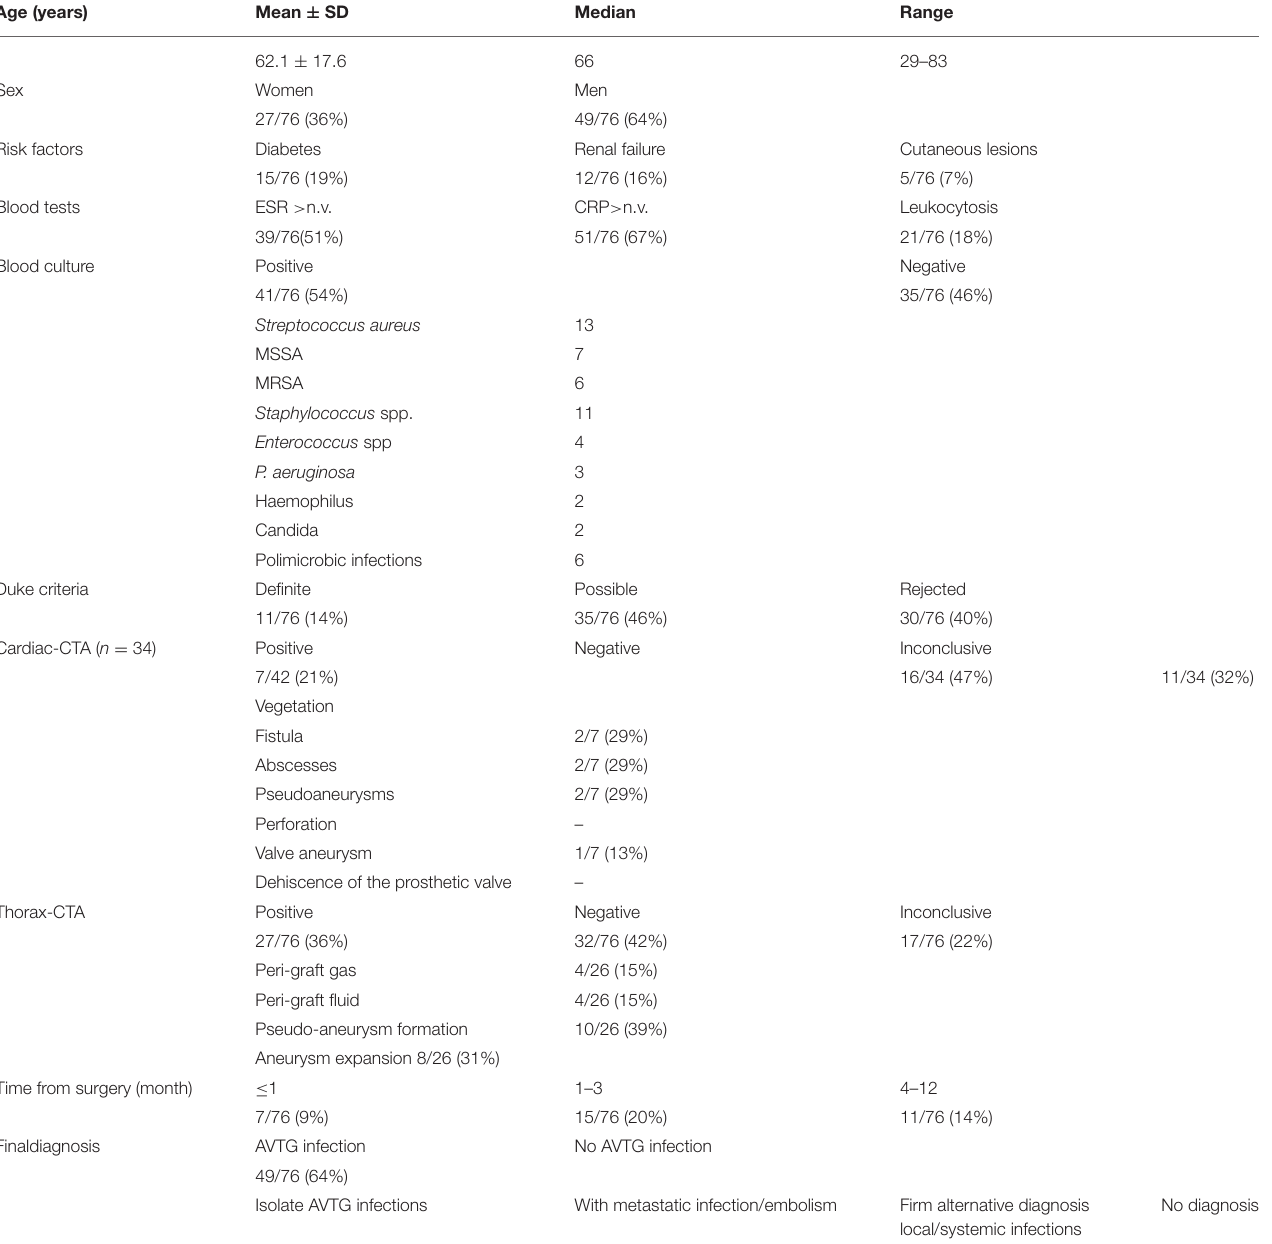
TABLE 1 | Summary of the characteristics of the Bentall